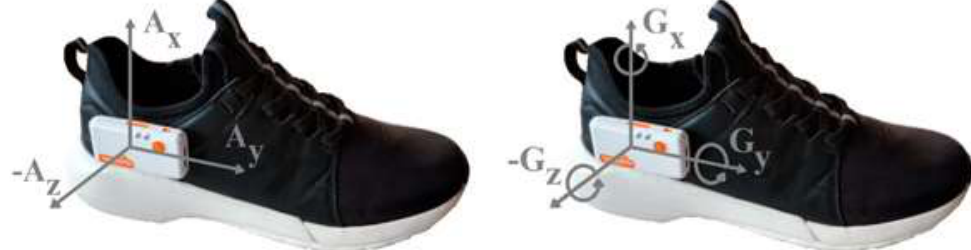
Figure 2. Axis alignment of the IMU attached to the right shoe of each participant.